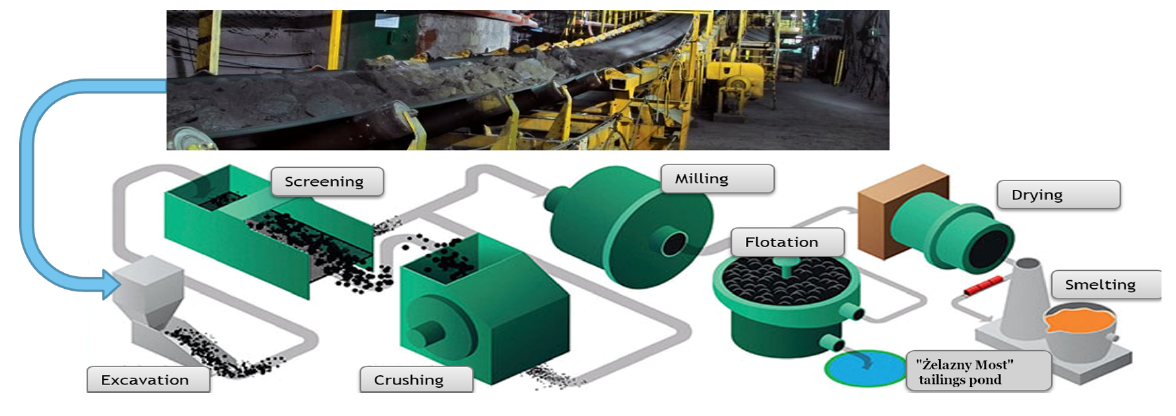
Figure 1. The processing